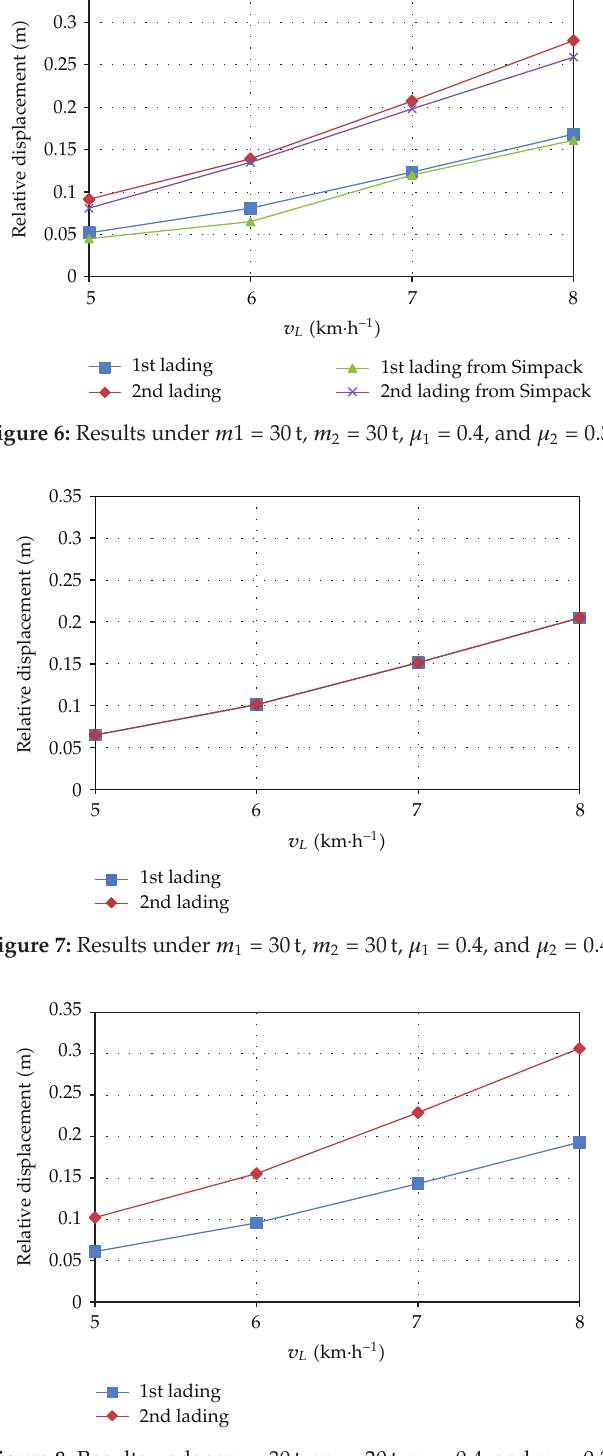
Figure 8: Results under m 1 (cid:10) 30t, m 2 (cid:10) 20t, μ 1 (cid:10) 0 . 4, and μ 2 (cid:10) 0 .